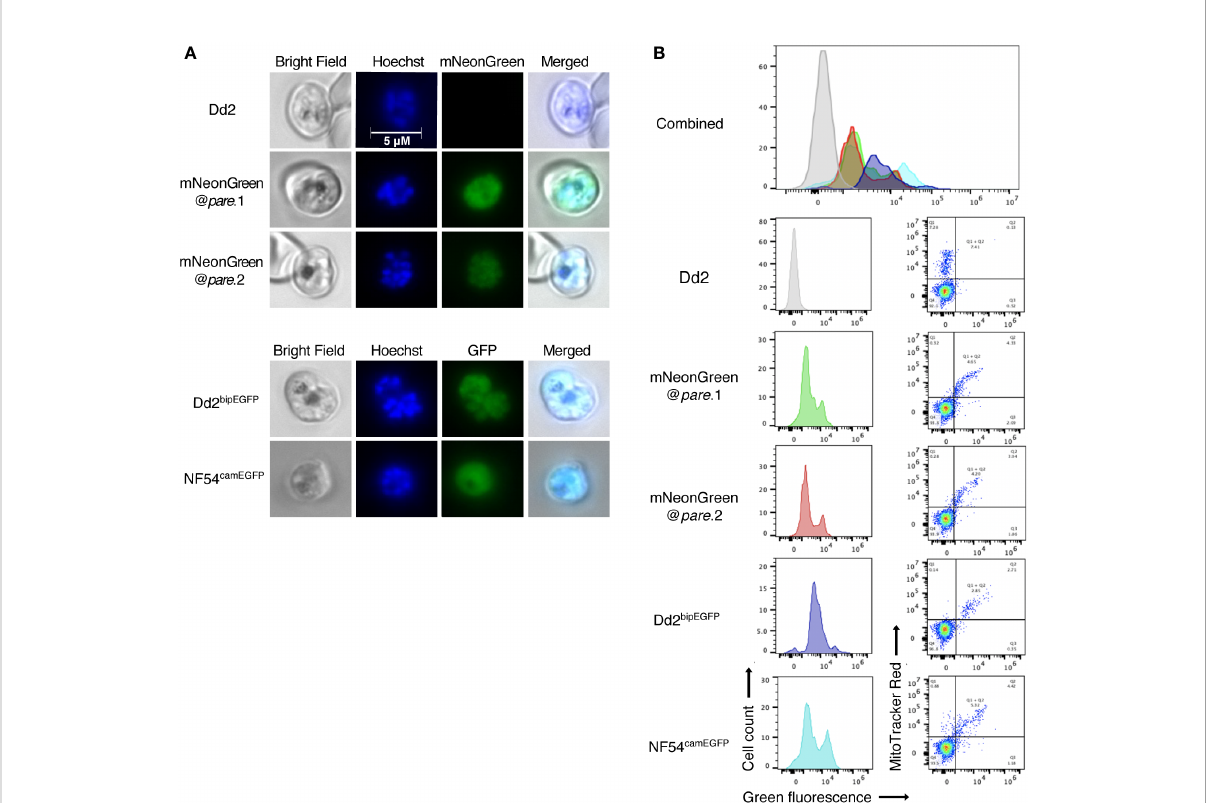
FIGURE 2 mNeonGreen fl uorescence in P. falciparum is comparable to GFP fl uorescent lines. (A) Mixed-staged parasites (Dd2, mNeonGreen@ pare. 1, mNeonGreen@ pare. 2, Dd2 bipEGFP , NF54 camEGFP ) were fi xed, stained with Hoechst DNA stain, and visualised using bright- fi eld and fl uorescence microscopy at 1000x magni fi cation. (B) Mixed-stage parasites (Dd2, mNeonGreen@ pare. 1, mNeonGreen@ pare. 2, Dd2 bipEGFP , NF54 camEGFP ) were stained with MitoTracker DeepRed and analysed on a fl ow cytometer. Quanti fi cation of green fl uorescent (GFP and mNeonGreen) and MitoTracker + cells was performed using FlowJo. All single-cell, parasitised RBCs (MitoTracker + ) were gated, and histograms of green fl uorescence were generated (GFP + or mNeonGreen +